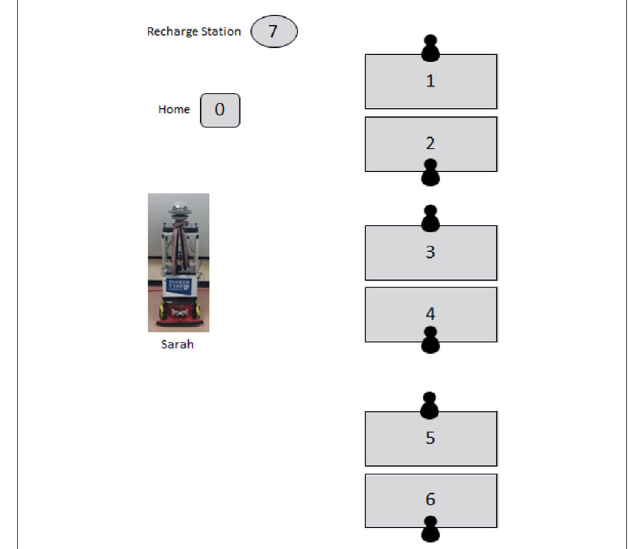
FigUre 2 | Label 1–6: workspace equipped with desktop computers, label 0: home position of the robot TB, and label 7: charging station for TB.